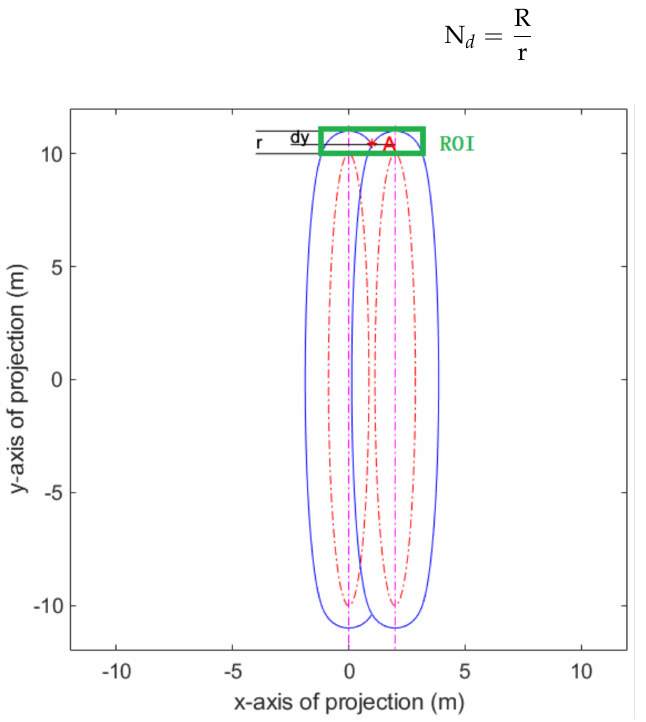
Figure 4. Projection interferogram of two torus. The area of interest (ROI) is shown in the green rectangle. A is the intersection point of the projection outer rings of two